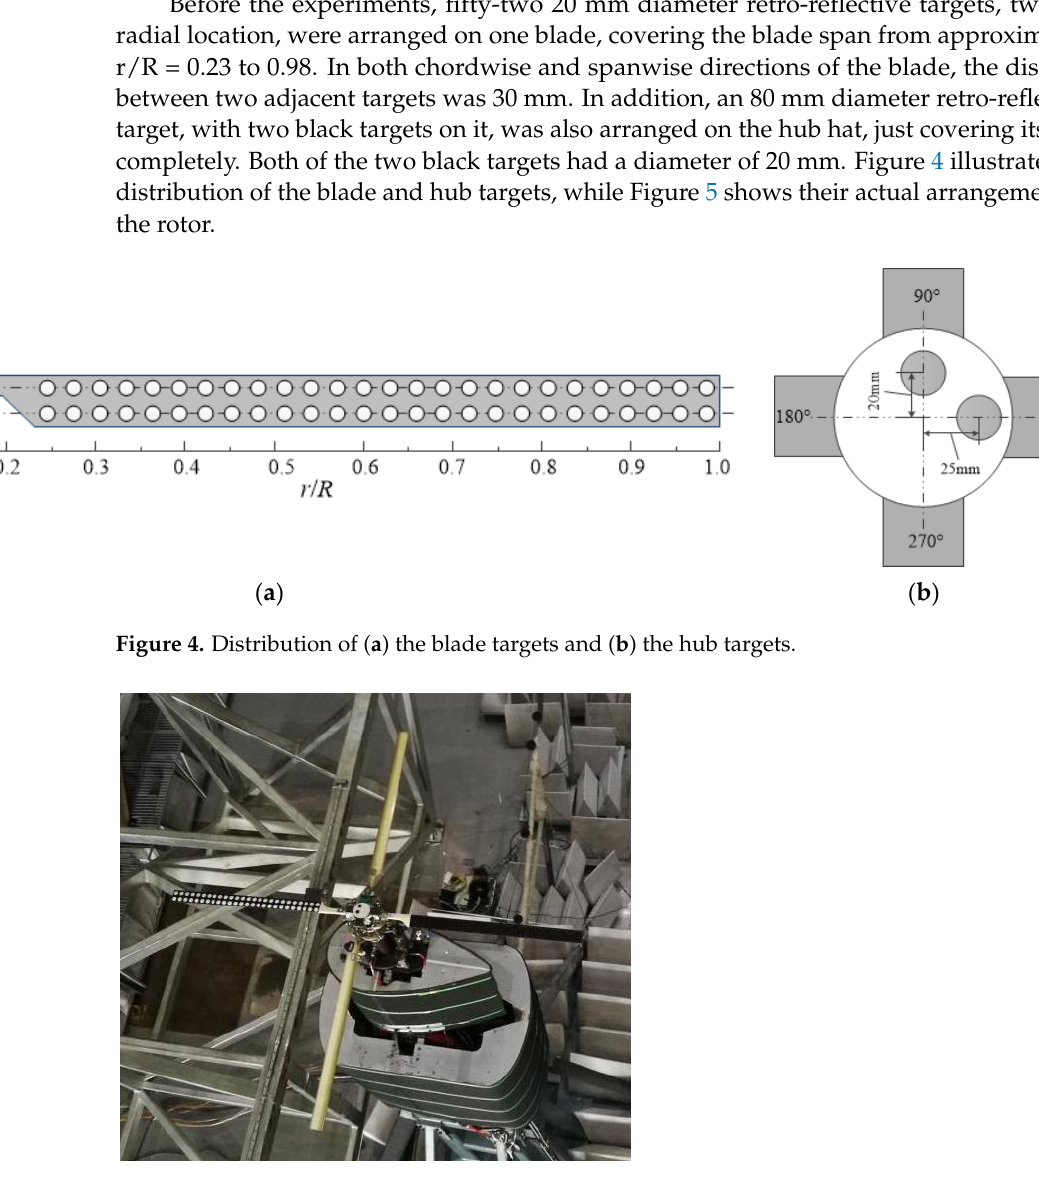
Figure 5. Arrangement of the blade and hub targets.